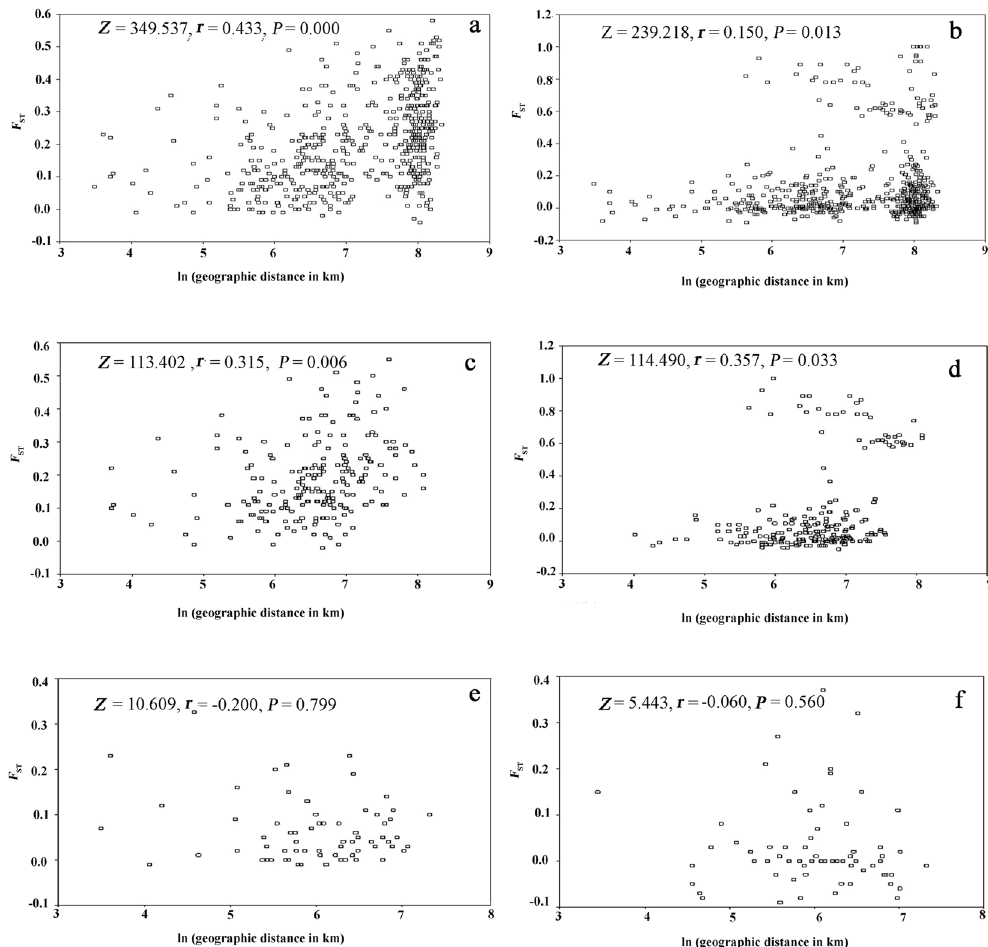
Figure 6. Correlation analysis between pairwise linearized F ST values and the logarithm of geographic distance in Chinese populations of Aphis gossypii based on microsatellites (( a ) total population; ( b ) eastern region group; ( c ) western region group) and combined COI and Cytb (( d ) total population; ( e ) eastern region group; ( f ) western region